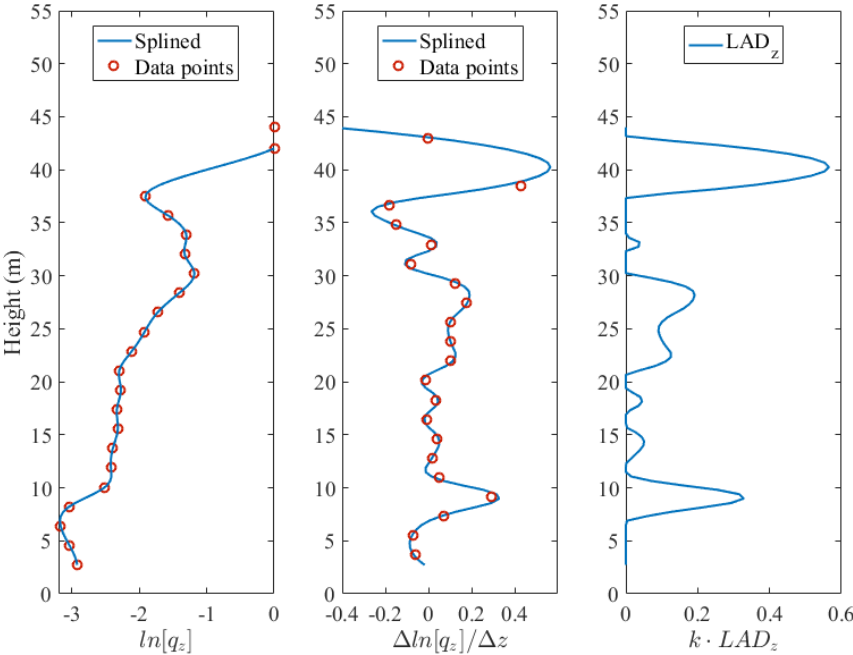
Figure A3. Values found at each step in calculating LAD and LAI (z) profiles. Here, ln [ q z ] is equal to − k · LAI (z) , and (cid:49)ln [ q z ] /(cid:49)z is identical to − k · LAD z .